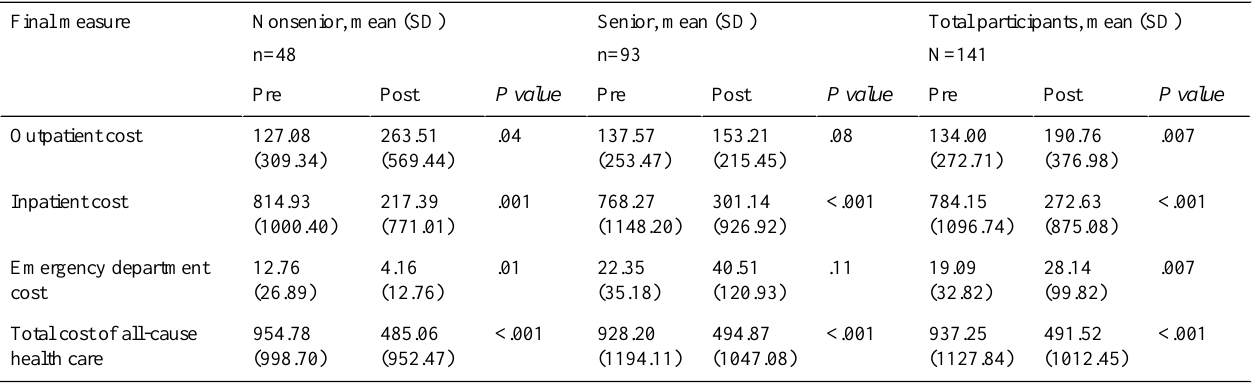
Table 4. Monthly average cost per patient (in US$) 6 months before (pre) and 6 months after (post) initiation of telehealth services in patients with cardiovascular diseases, stratified according to age.